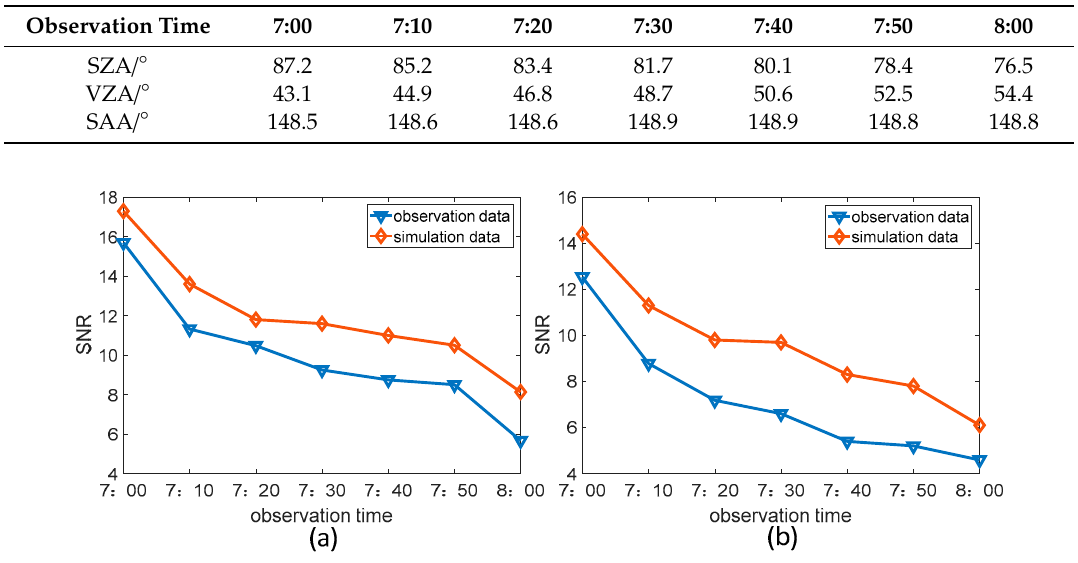
Figure 12. Comparison between the observation results and the simulation results ( a ) Hip29655 ( b ) Hip30343.